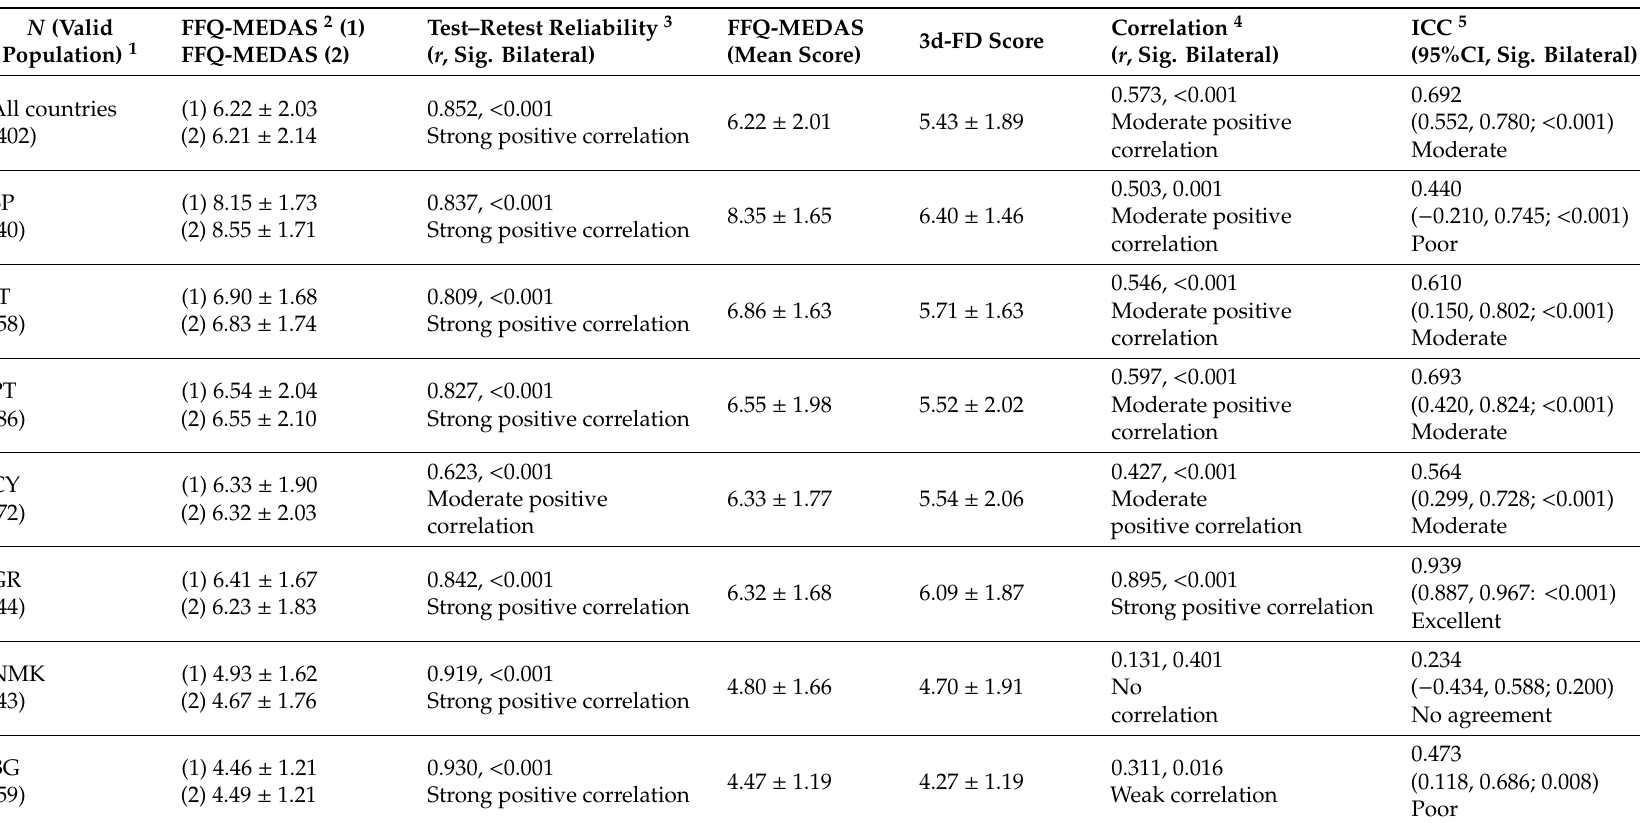
Table 2. Global and single country 14-item Mediterranean Diet Adherence Screener (14-MEDAS) vs. 3-day food diary (3d-FD) scores (mean ± SD). Results of the validation analyses for test reliability, association, and